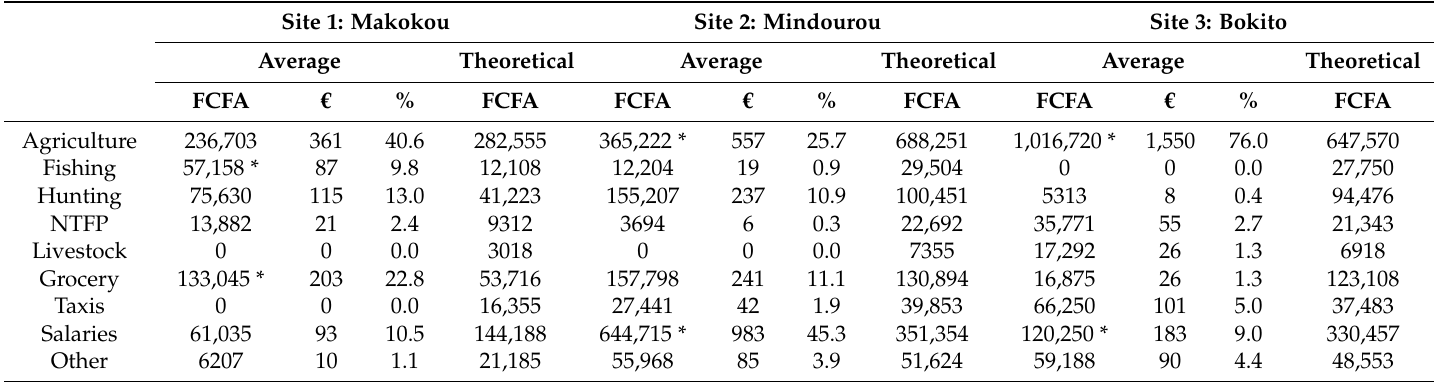
Table 2. Distribution of average income per household between the main activities in FCFA (Central African Franc), in € (Euro) and in proportion (theoretical income under hypothesis of independence of the two